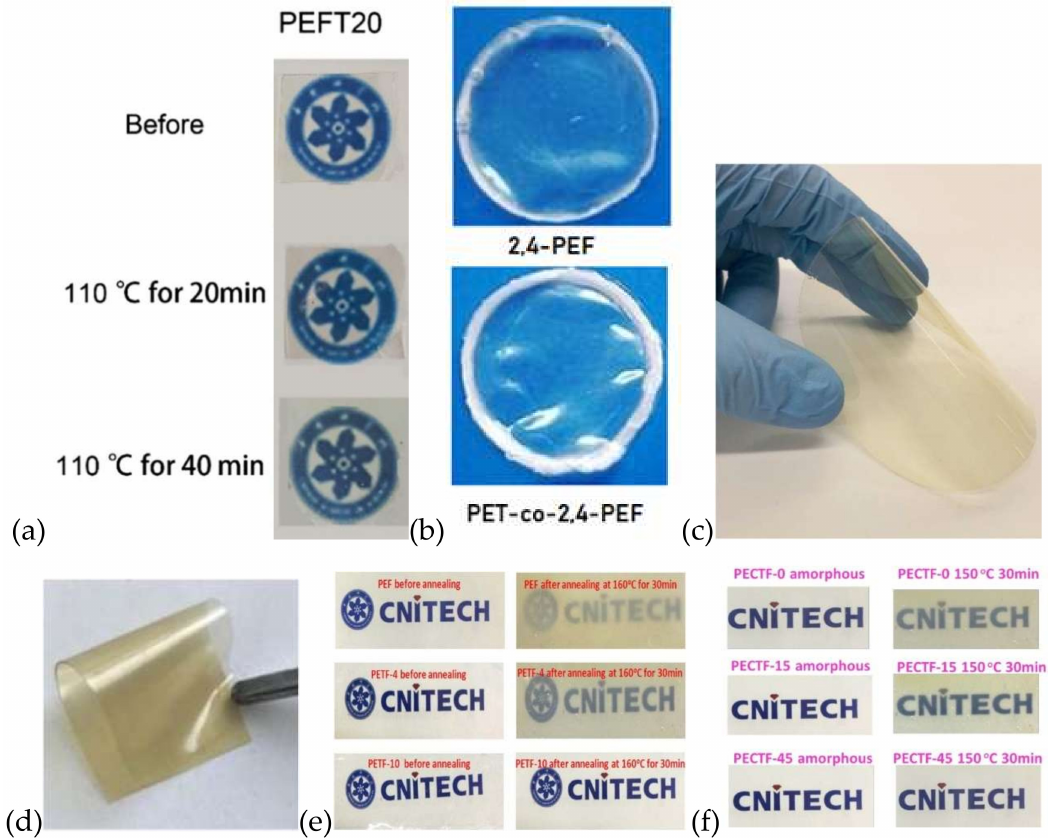
Figure 22. Images of films of various FDCA-based copolymers: ( a ) PEFT20 [40], ( b ) 2,4-PEF and PET- co -2,4-PEF [44], ( c ) PBF90Bf10 [63], ( d ) PPF- co -PPCH 90 [61], ( e ) PEF, PEF- co -PCBDOF copolymers [35], ( f ) PCDHDMF and PEF- co -PCDHDMF- co -PCBDOF copolymers